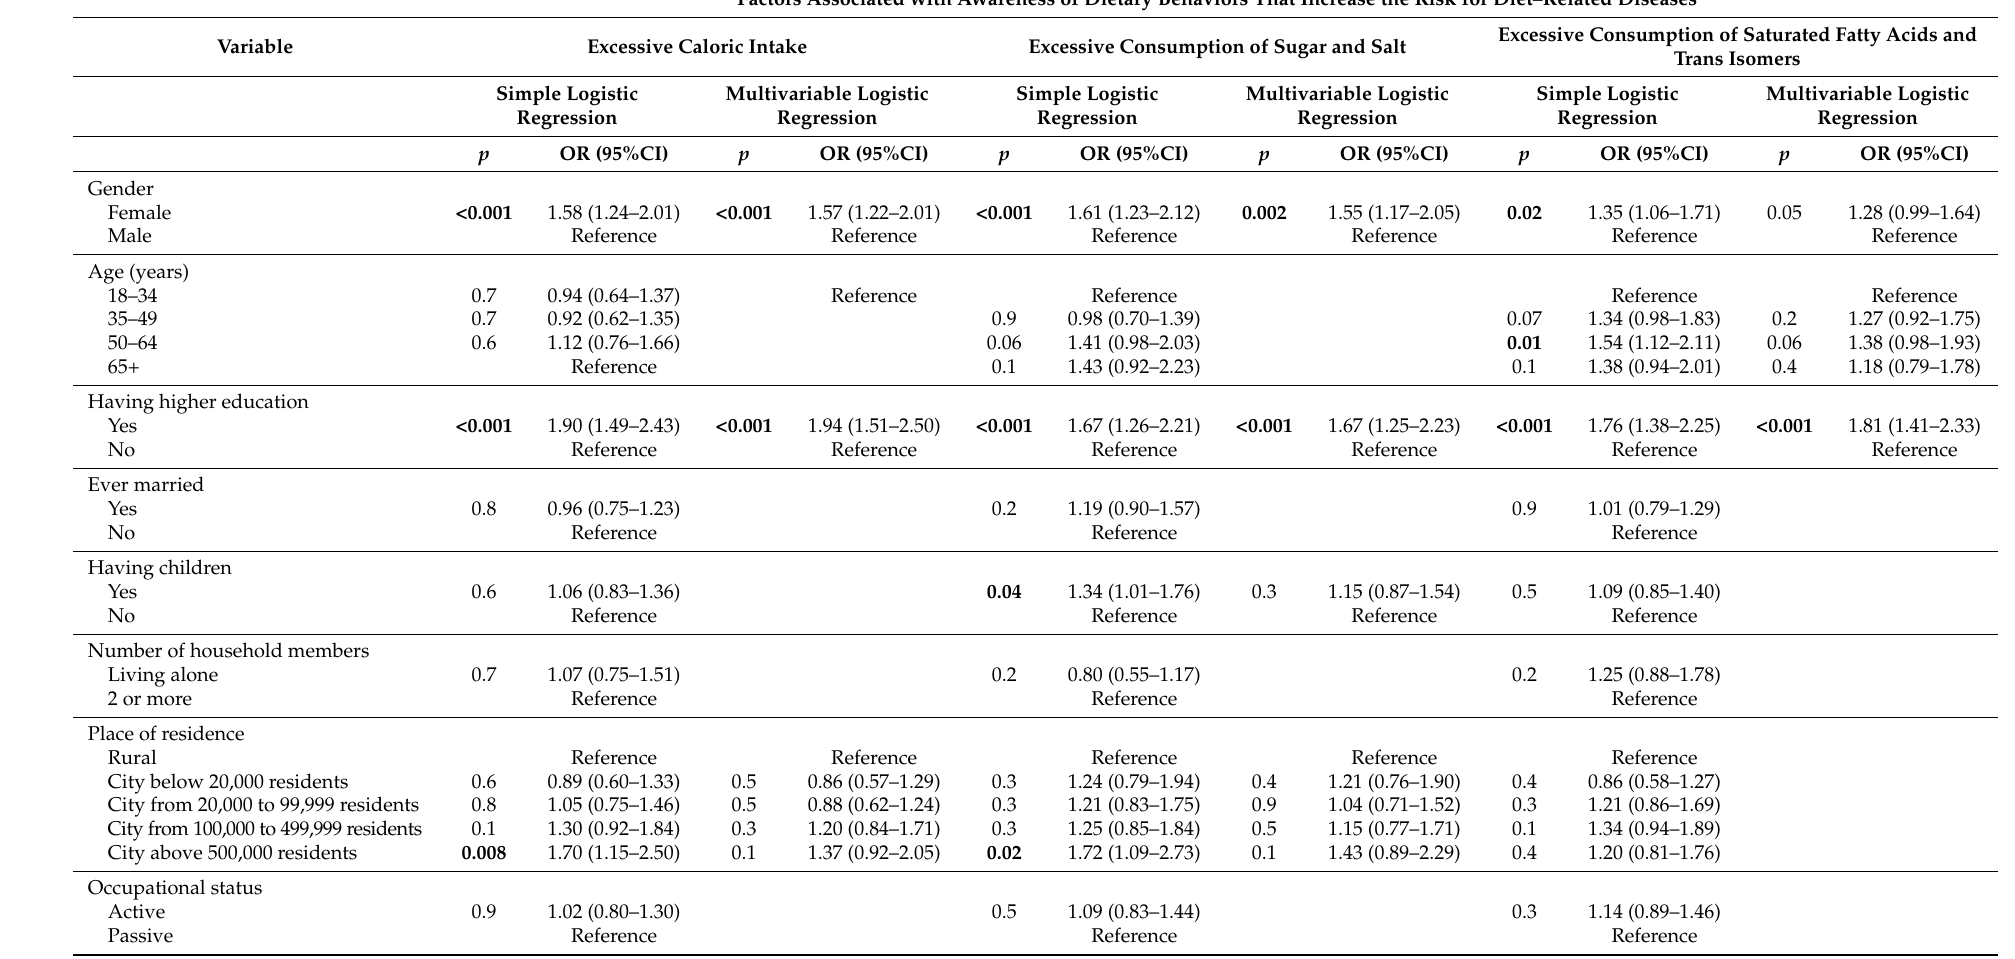
Table 6. Awareness of dietary behaviors that increase the risk for diet-related diseases ( n = 1070). Factors Associated with Awareness of Dietary Behaviors That Increase the Risk for Diet–Related